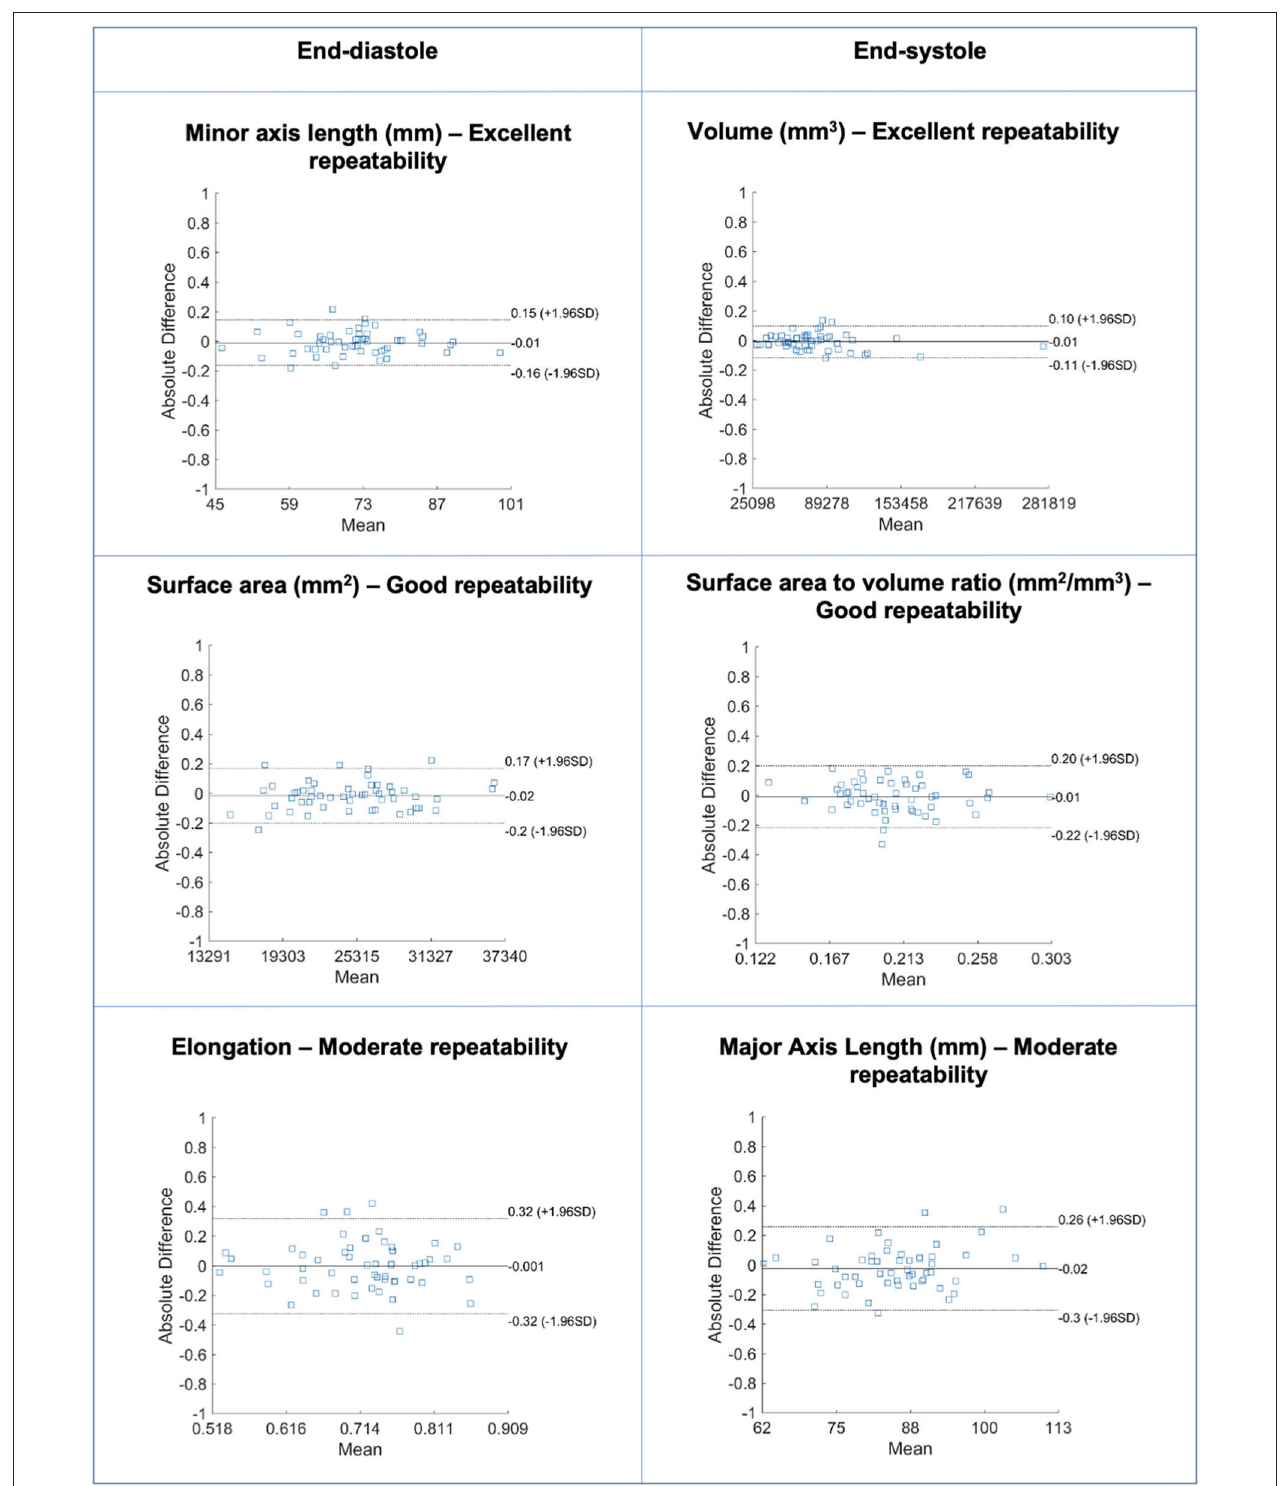
FIGURE 4 | Bland-Altman plots for selected RV blood pool shape features in end-diastole (left) and end-systole (right) with different levels of repeatability. Differences in Bland-Altman are calculated after normalizing radiomics in the range [0–1] to facilitate comparison among different features. All features are unitless. RV: right ventricle.